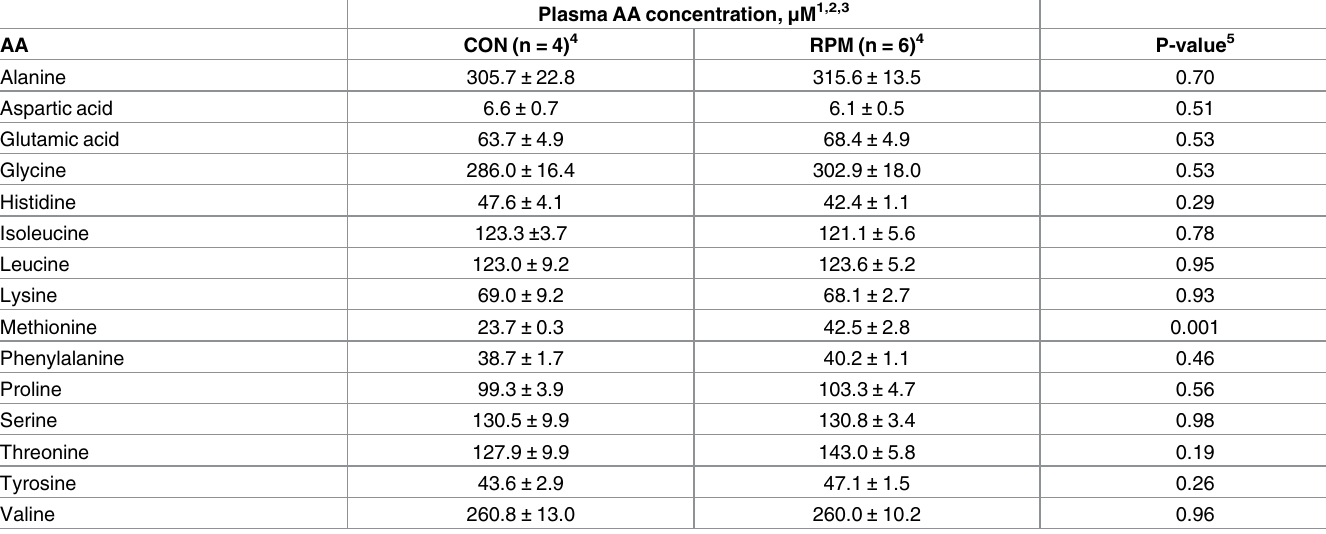
Table 2. Plasma amino acids (AA) concentrations at 12 hour after rumen-protected methionine (RPM)